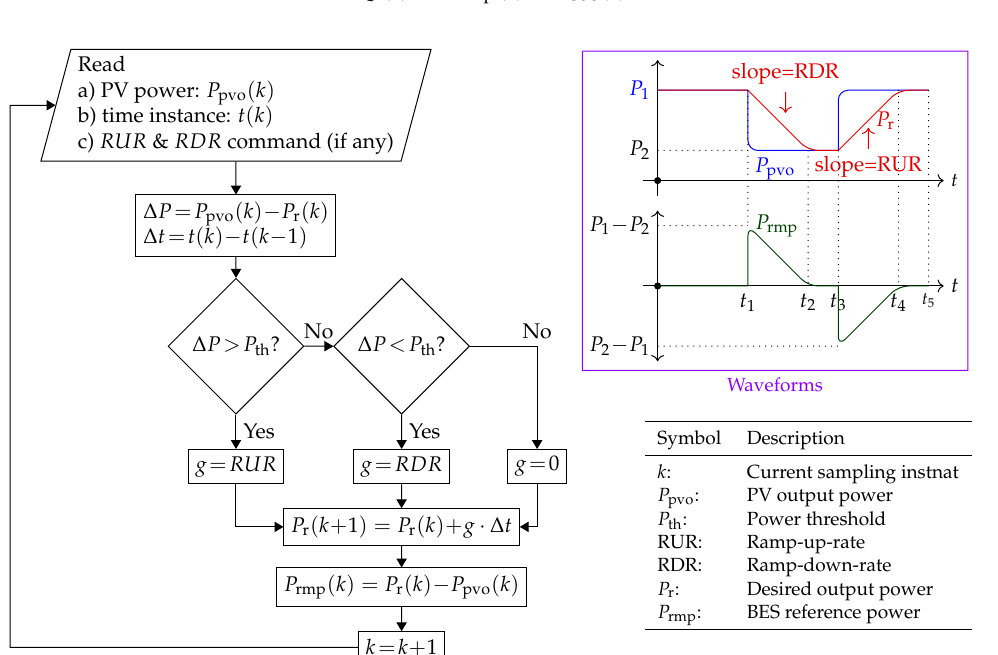
Figure 9. Flowchart to calculate power ramp reference for the